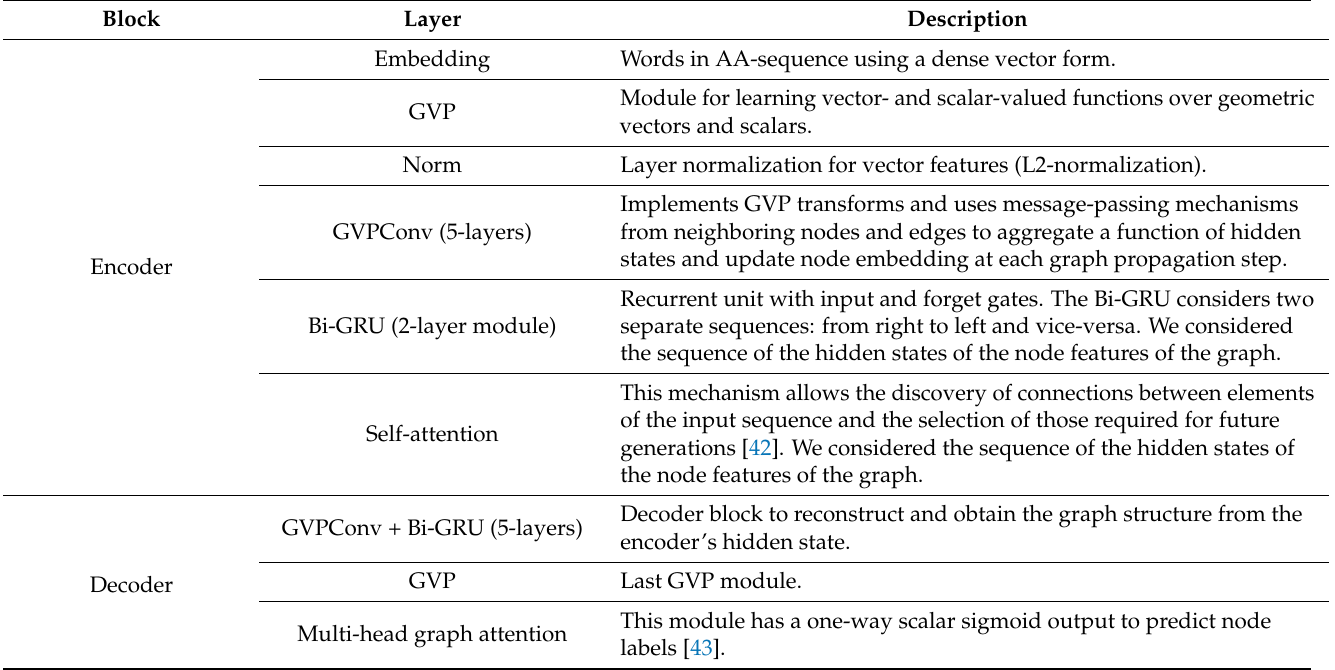
Table 3. Model architecture and implementation